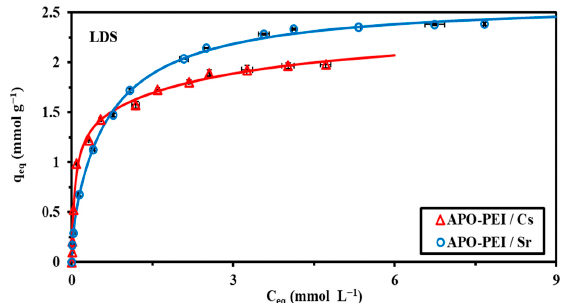
Figure A14. Modeling of Cs(I) and Sr(II) sorption isotherms (onto APO-PEI beads) using the Langmuir dual site model (LDS) (for experimental conditions, see Figure A12).